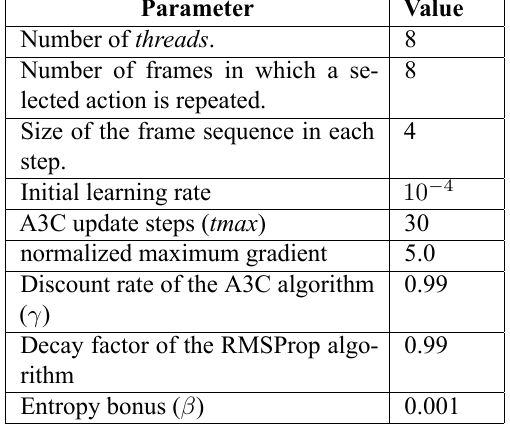
Table 3. Learning Parameters (Mnih et al., 2016). Parameter Value Number of threads .